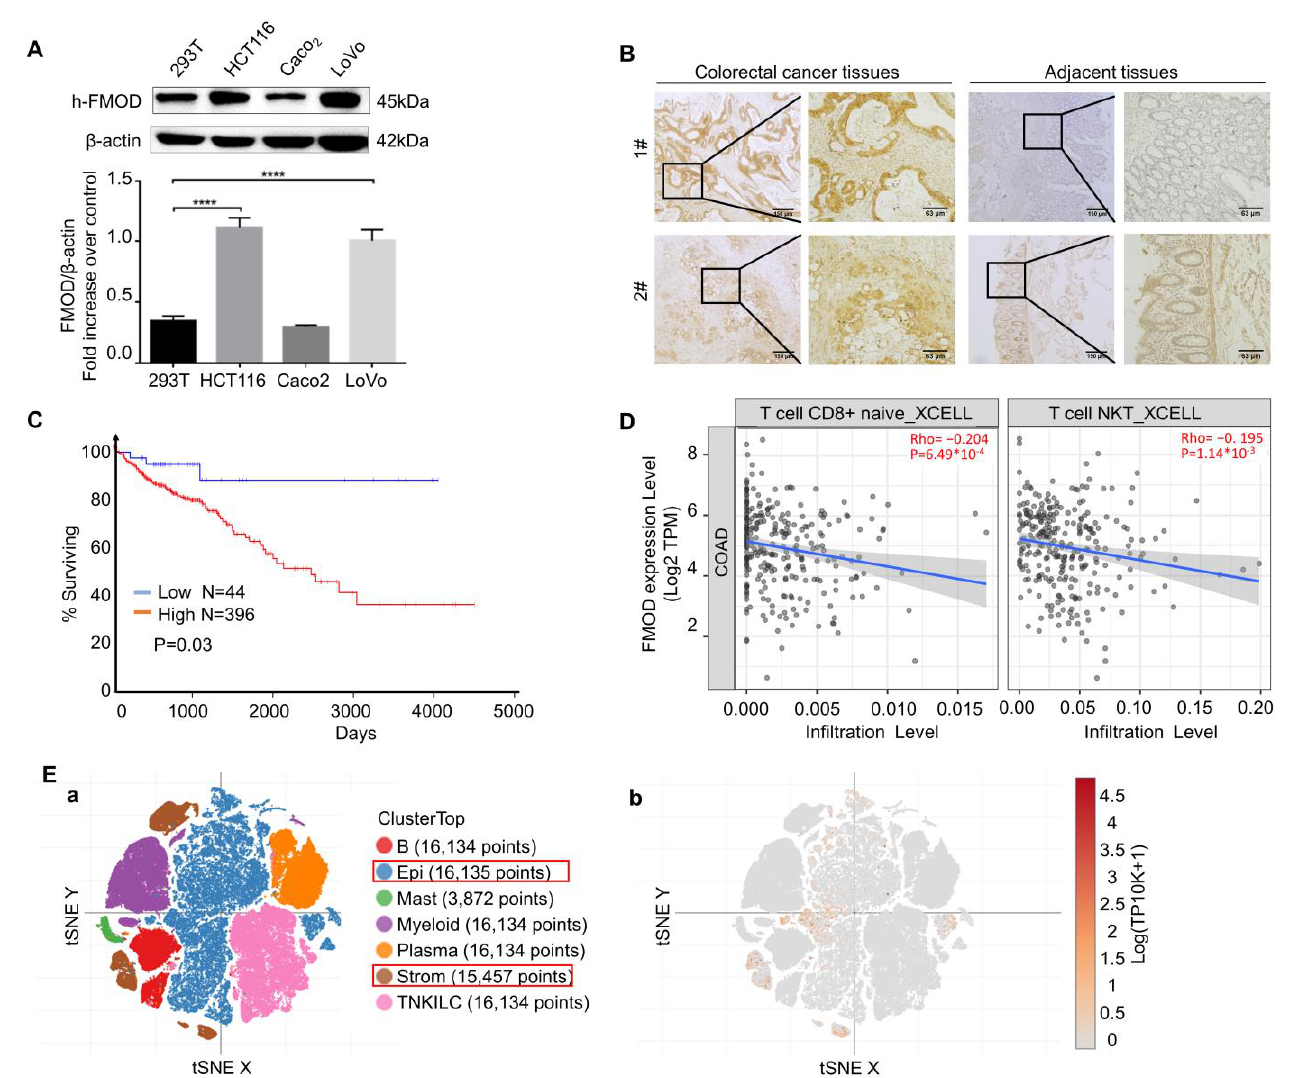
Figure 1. The expression of FMOD is associated with CRC progression. ( A ), Protein expression levels of FMOD in CRC cell lines compared with 293T cells were measured by Western blotting. ( B ), IHC staining of FMOD in CRC and adjacent tissues. Adjacent tissues located more than 2 cm away from the malignant tumor edge and taken out by experienced surgeons. ( C ), Kaplan – Meier survival analysis and log-rank test showed the overall survival of CRC patients who were FMOD-positive ( n = 398) vs. FMOD-negative ( n = 44). Data from OncoLnc. ( D ), Correlation between FMOD expression levels and CD8 + T cell and NKT cell infiltration levels. ( E ), Single-cell analysis of FMOD in CRC tissues. ( a ) Tissue clusters in colorectal cancer. ( b ), FMOD is mostly expressed in the epithelium and stroma. **** means p ＜ 0.0001.